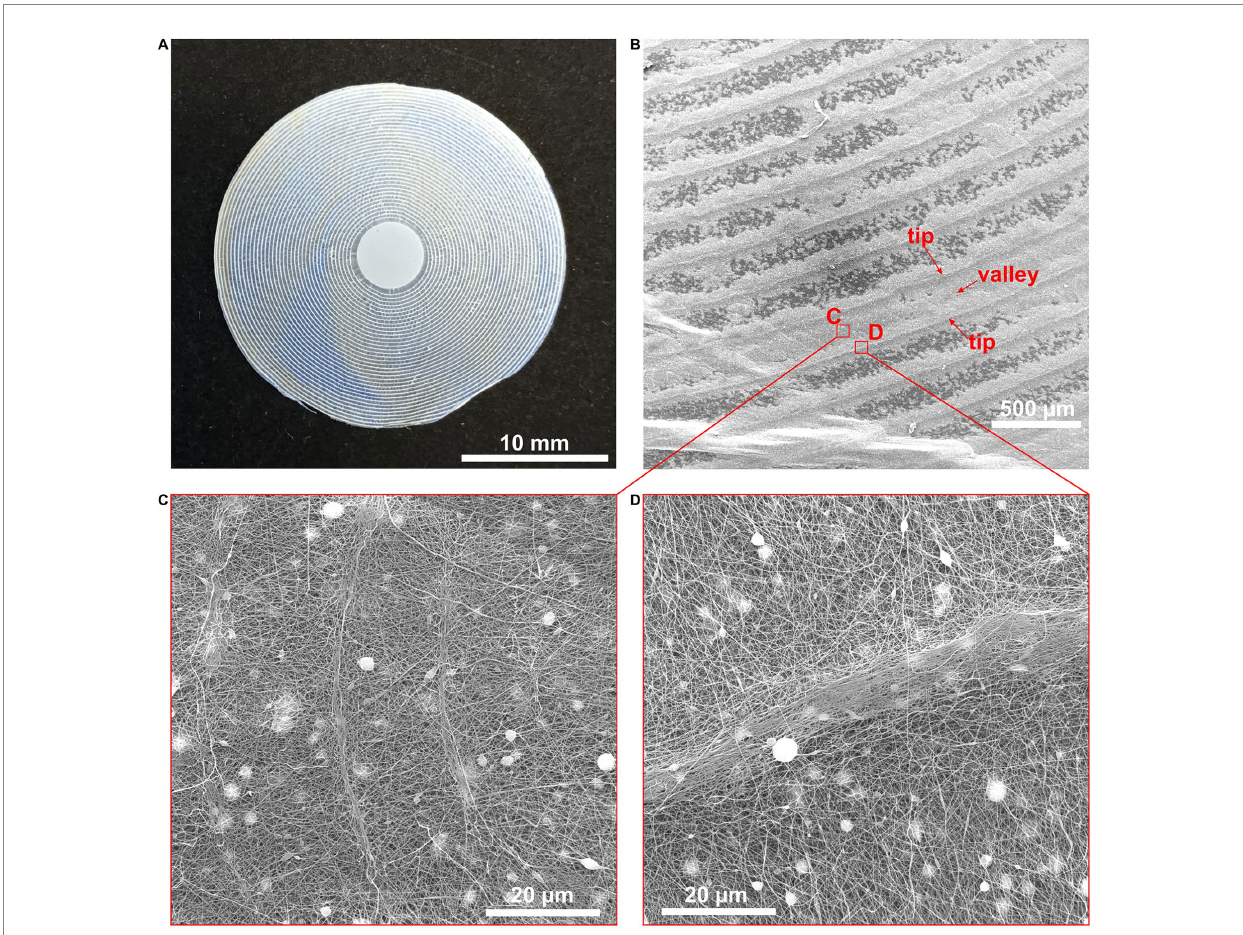
FIGURE 9 (A) Macroscopic image of the nonwoven layer peeled off from the triangular surface structure. One can see small distortions where the fibers adhered to the tips of the surface structure. (B) SEM-image of the nonwoven layer shown in (A) . (C) Magnified view of the nonwoven layer between two tips of the triangular surface structure. (D) Magnified view of the nonwoven layer where the nanofibers adhered to the tips of the triangular surface structure. However, the nonwoven nanofiber layer looks neither faulty nor damaged in the areas where it had contact with the tips of the surface structure.